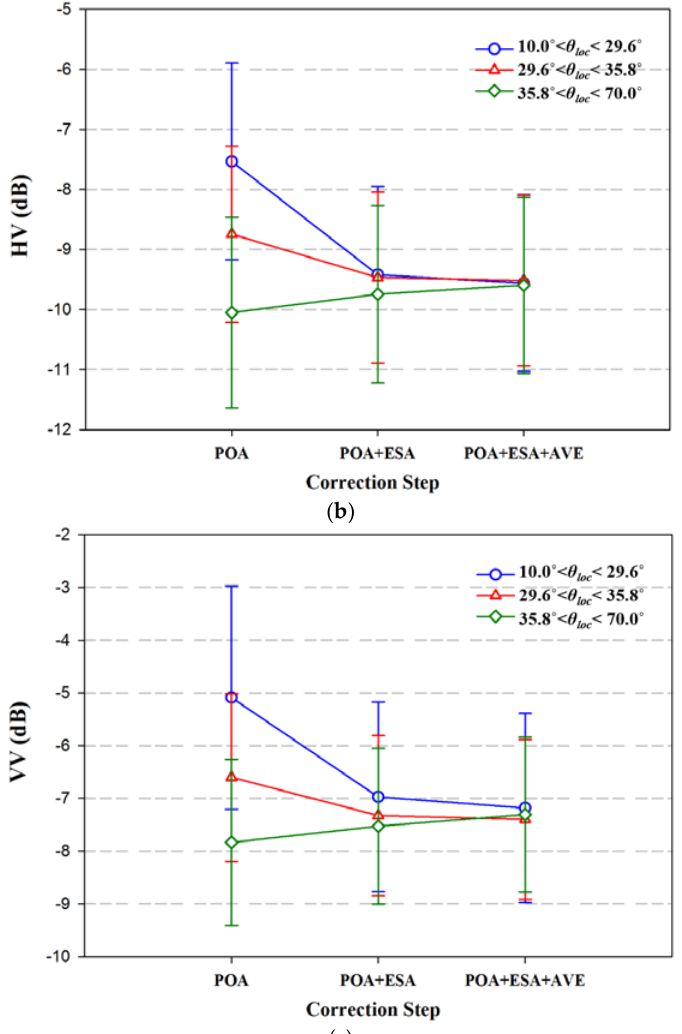
Figure 19. The statistical characteristic (Mean and Standard deviation) of backscattering coefficients for different correction steps in different ranges of local incidence angles (29.6° and 35.8° represents 33.3th and 66.6th percentile of local incidence angles): ( a ) HH; ( b ) HV; ( c ) VV.